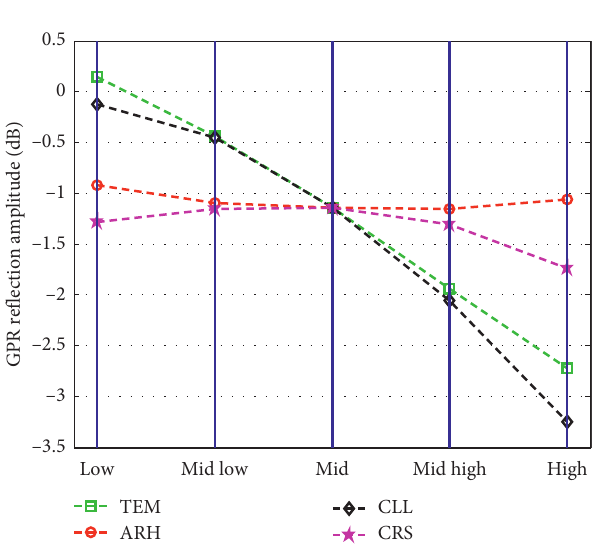
Figure 8: Sensitivity analysis